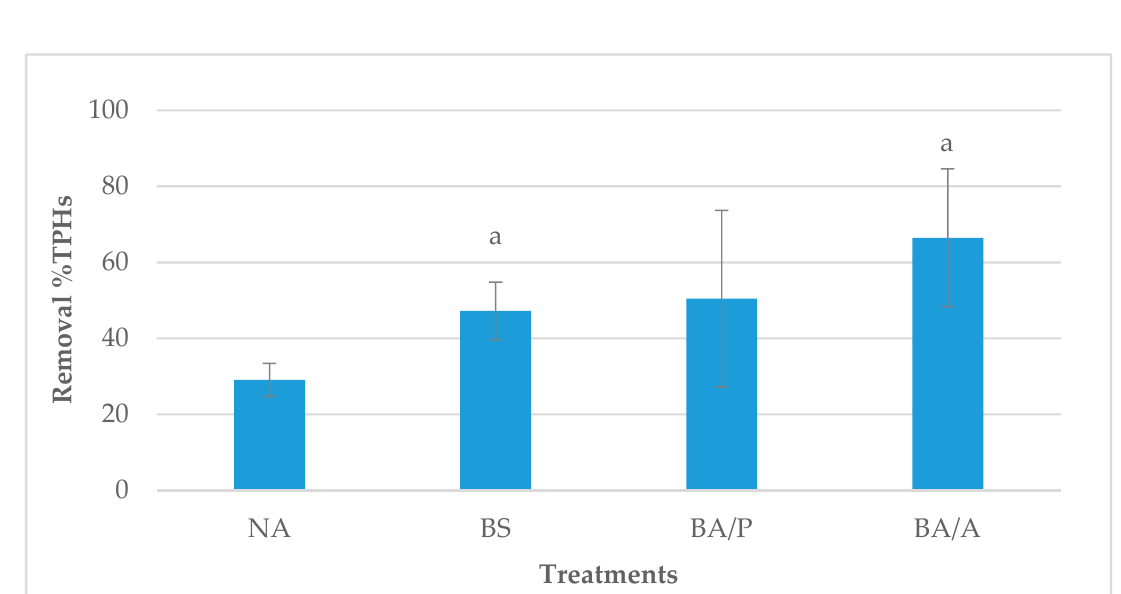
Figure 5. Removal percentage of total petroleum hydrocarbons (TPHs) (mean values, standard deviations, n = 3) for the different treatments: natural attenuation (NA), biostimulation (BS), bioaugmentation with inoculum pre-grown in petroleum (BA/P) and bioaugmentation with inoculum pre-grown in acetate (BA/A). a—significant differences comparing each treatment with NA.